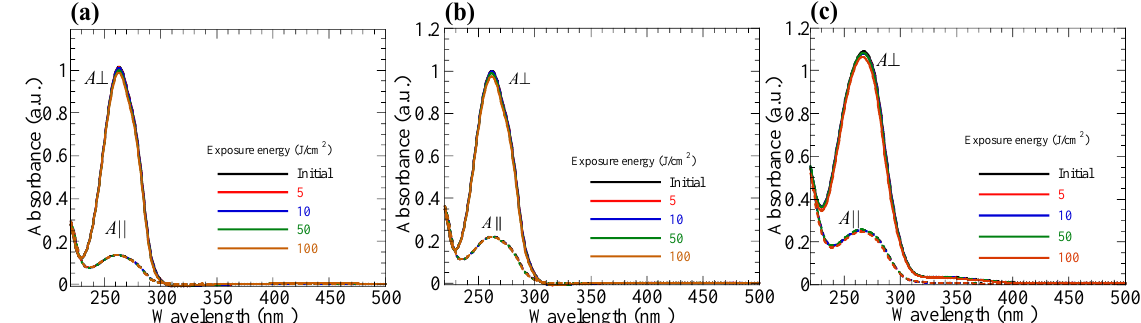
Figure 12. Changes in the polarized absorption spectra when hyrolyazed ( a ) PN10 , ( b ) PN20 , and ( c ) PN50 films are exposed to LP 365-nm light with E parallel to the orientation direction.